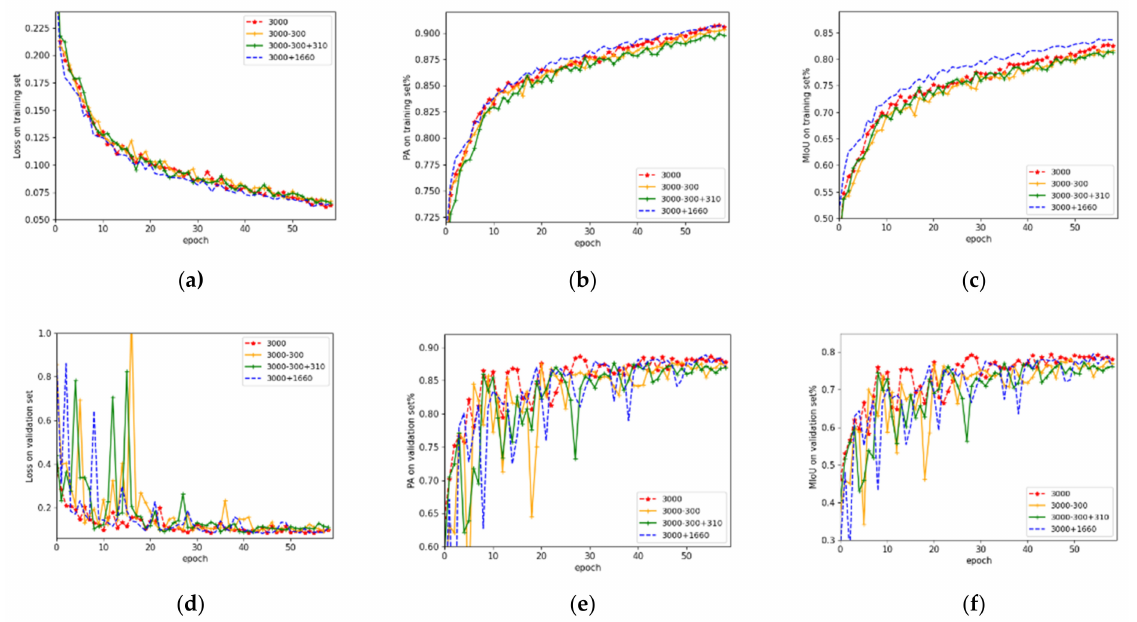
Figure 8. Results of the proposed network on dataset 2. ( a ) Training loss; ( b ) training PA; ( c ) training MIoU; ( d ) validation loss; ( e ) validation PA; ( f ) validation MIoU.